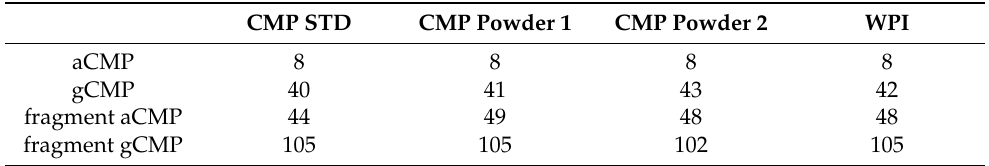
Table 1. Count of aCMP, gCMP, fragment aCMP and fragment gCMP in four samples (CMP STD, CMP powder 1, CMP powder 2 and